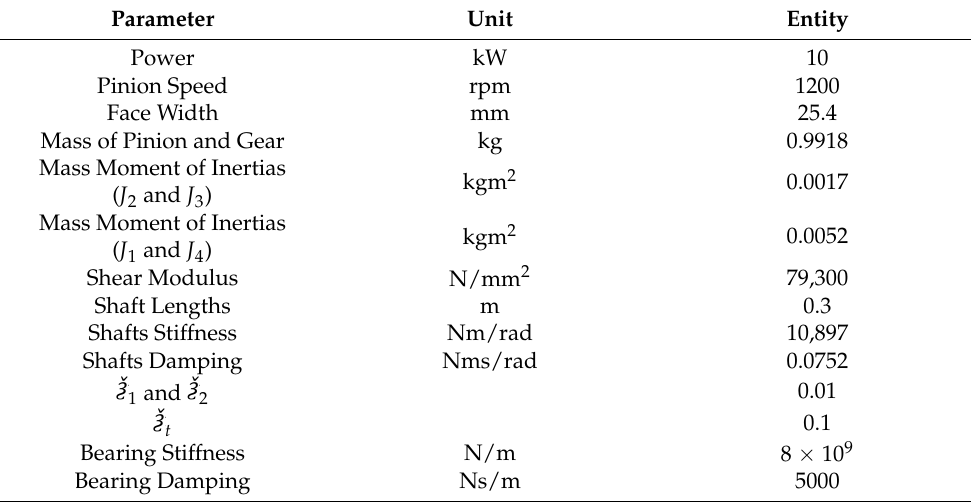
Table 2. Constant coe ffi cients of the dynamic model [43–45].